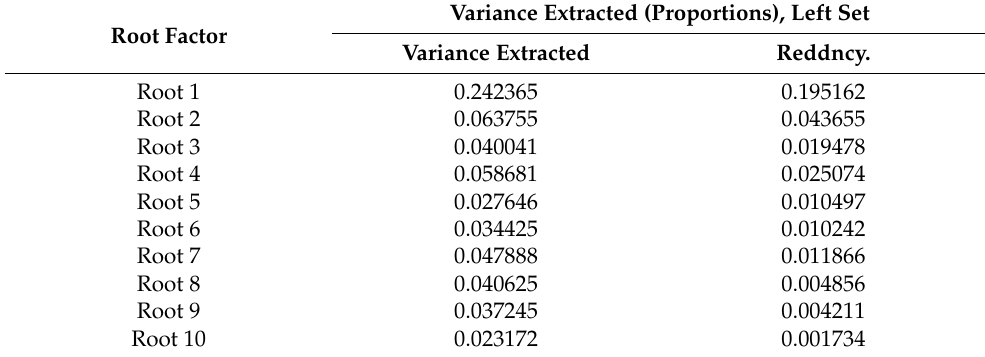
Table 4. Proportions of extracted variance for the left